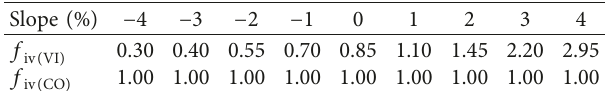
Table 2: Slope related with f condition). Slope (%)